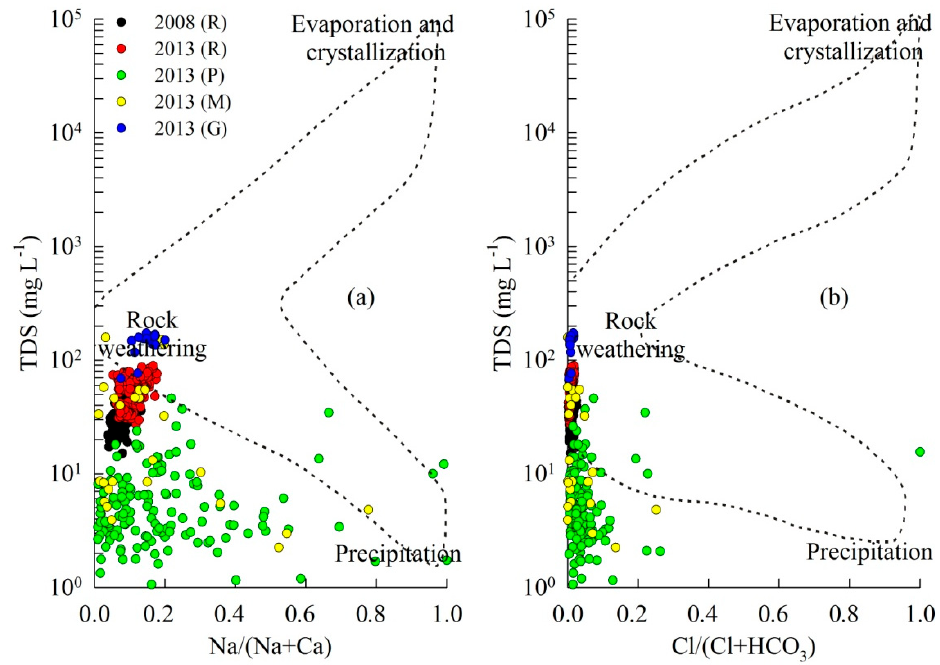
Figure 7. The Gibbs plots of total dissolved solids (TDS) versus molar Na/(Na + Ca) ( a ) and Cl/(Cl + HCO 3 ) ( b ) for river water (R), precipitation (P), meltwater (M) and groundwater (G) at the Hailuogou basin over two melt seasons in 2008 and 2013.